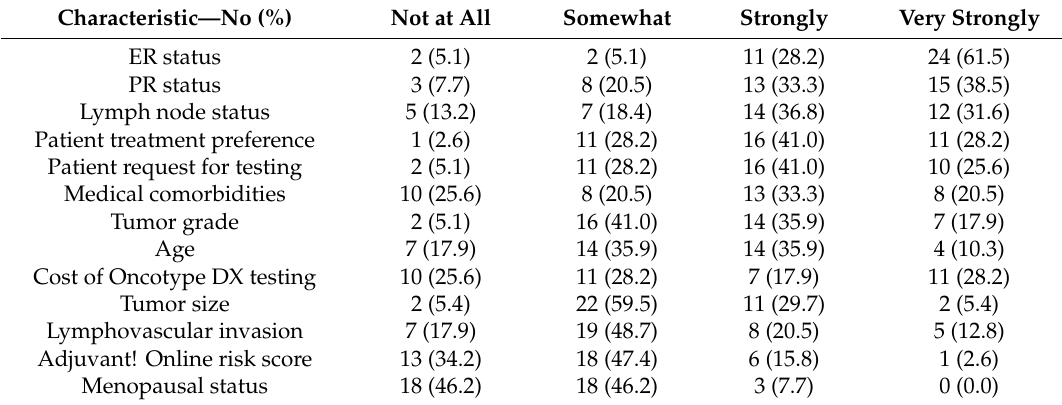
Table 2. Survey question: How strongly do the following factors influence your use of Oncotype DX? (Not at all, Somewhat, Strongly or Very